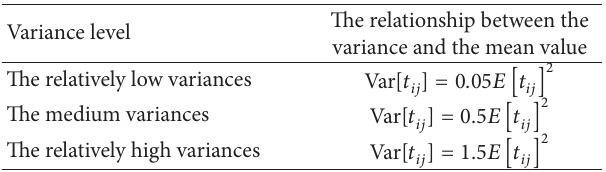
Table 1: The relationship between the variance and the mean value for each variance